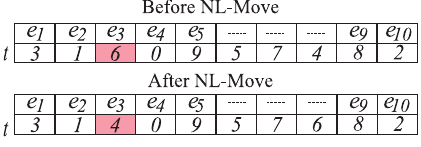
Figure 1. NL-Move Example.